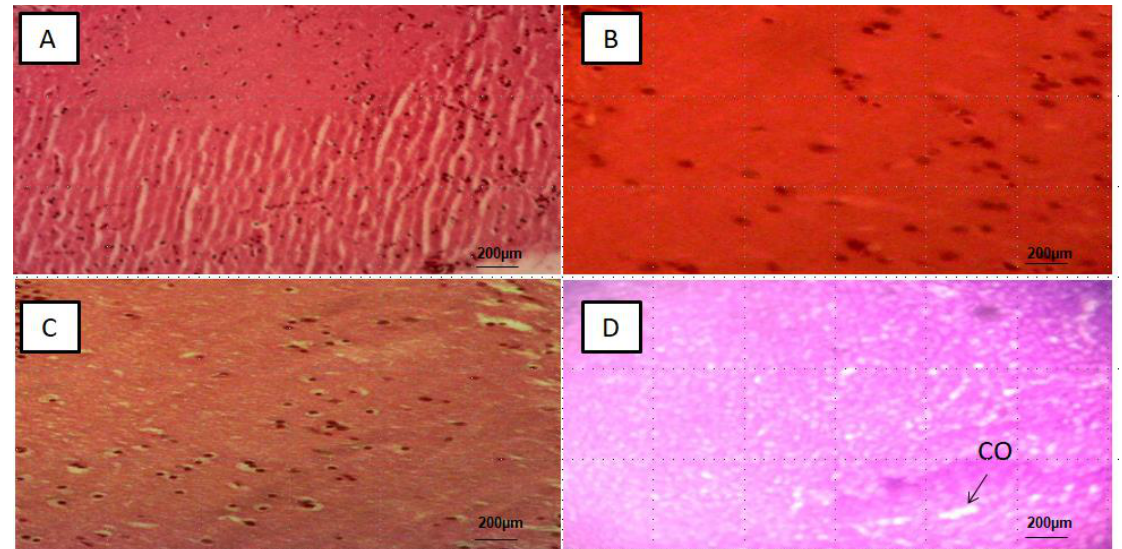
Figure 4. Representative photomicrograph of kidney tissue: ( A ) control group with normal tissue, ( B ) MP-LOW, ( C ) MP-MED, and ( D ) MP-HIGH, showing interstitial inflammation (II), interstitial oedema (IO) and tubular destruction (TD).